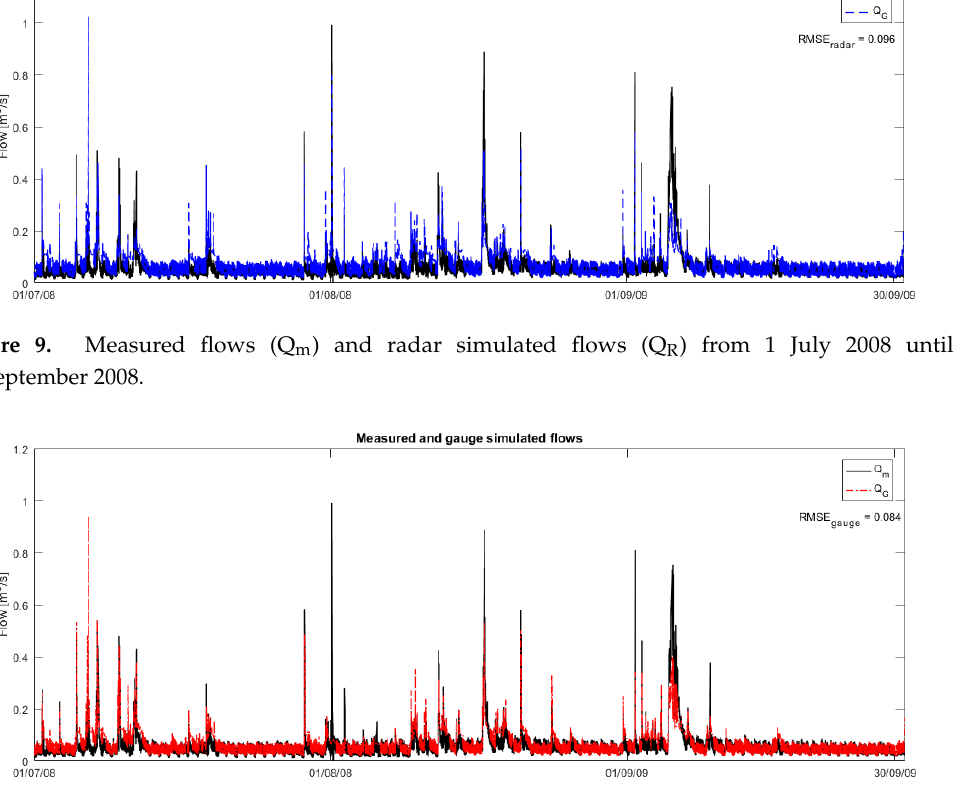
( a ) ( b ) Figure 11. Flows ( a ) and peak flows ( b ) for events on 07 July 2008 starting at 15:00. Q F Ens Radar, Q F Ens STEPS , Q F Det , Q m , Q G and Q R are, respectively, forecasted radar ensemble flows, forecasted STEPS ensemble flows, forecasted deterministic flow, measured flow, estimated gauge flow and estimated radar flow.